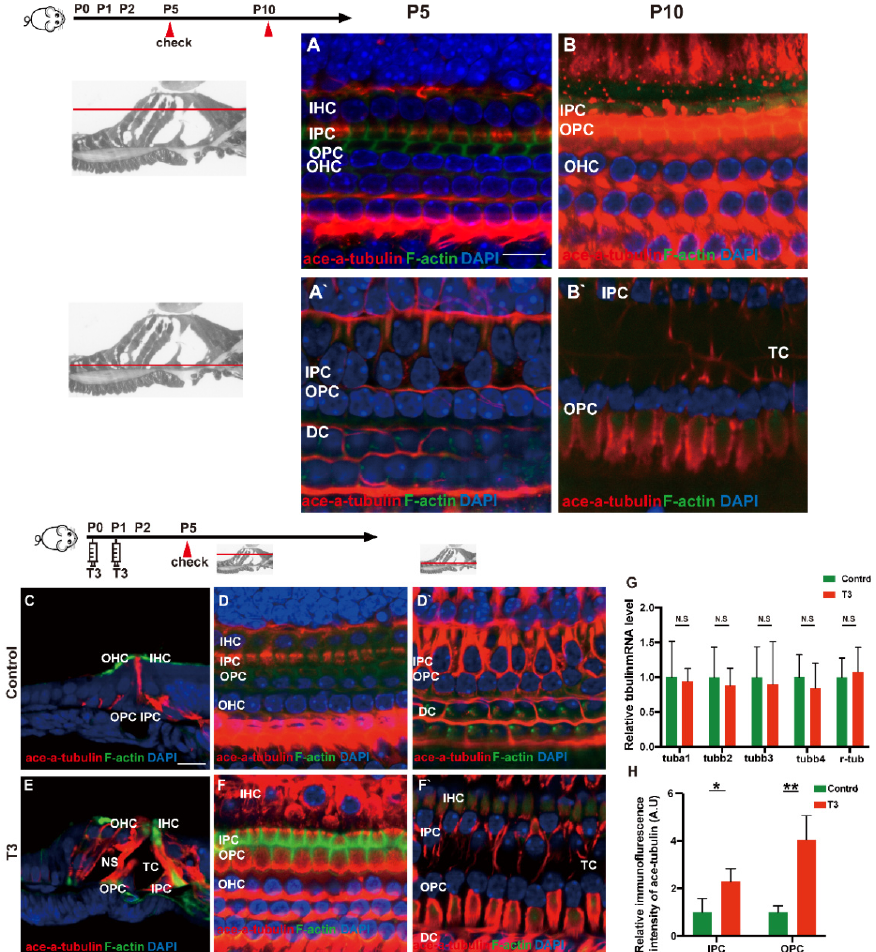
Figure 5. T3 influences the growth of PCs via acetylated α -tubulin. ( A , B ) Staining of F-actin (green) and acetylated α -tubulin (red) in hair cells and ( A ’, B ’) showing those at the layer of PC nuclei